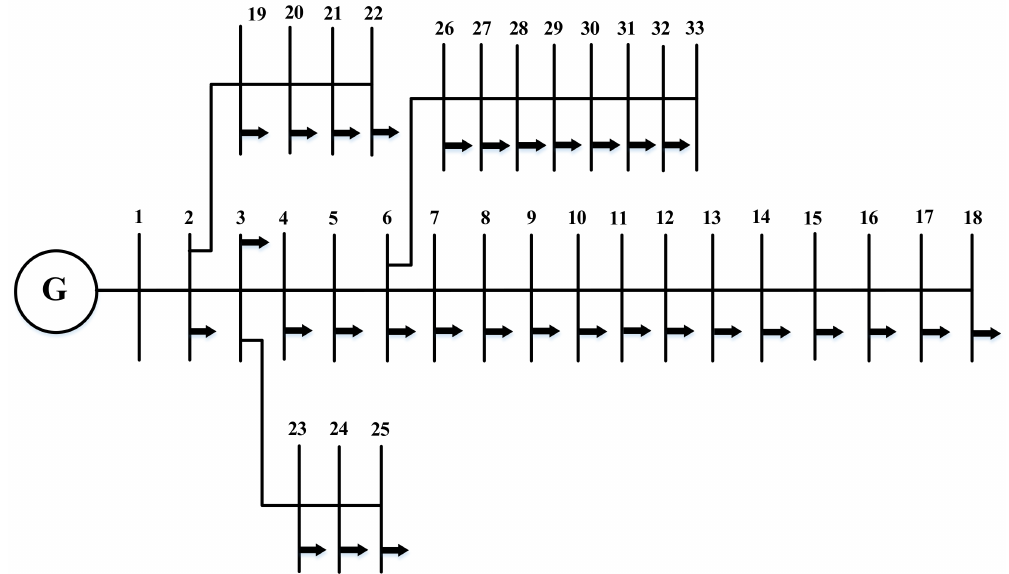
Figure 3. Single line diagram of the IEEE 33-bus radial distribution system.